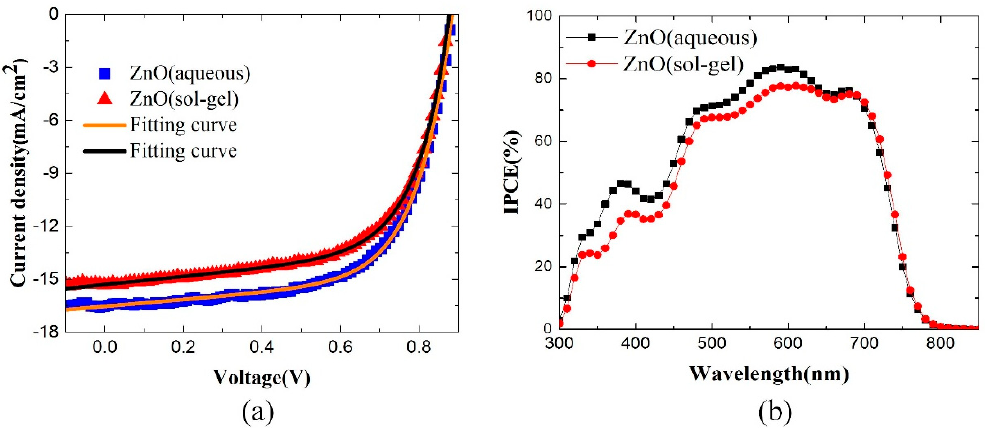
Figure 2. ( a ) J–V characteristics of inverted OSCs with the ZnO selective layer using aqueous or sol-gel under the simulated AM 1.5G illumination of 100 mW/cm 2 ; ( b ) the IPCE curves of PBDB-T:IT-M OSCs.